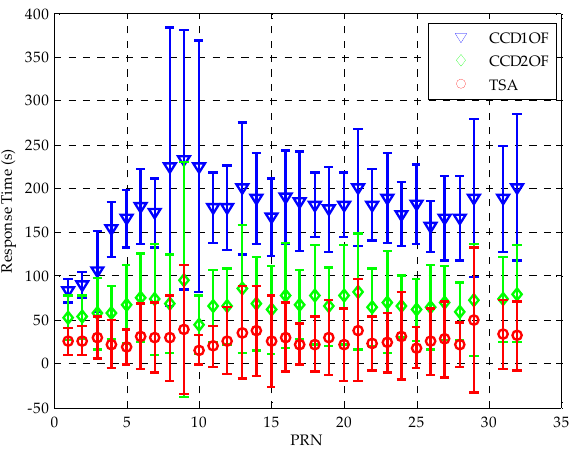
Figure 10. Comparison of the overall average response time to anomaly with respect to PRN.